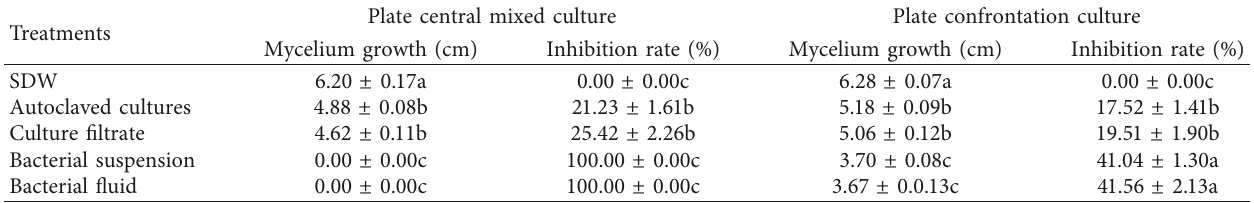
Table 1: The effect of P. fluorescens on the mycelial growth of P. digitatum . Treatments